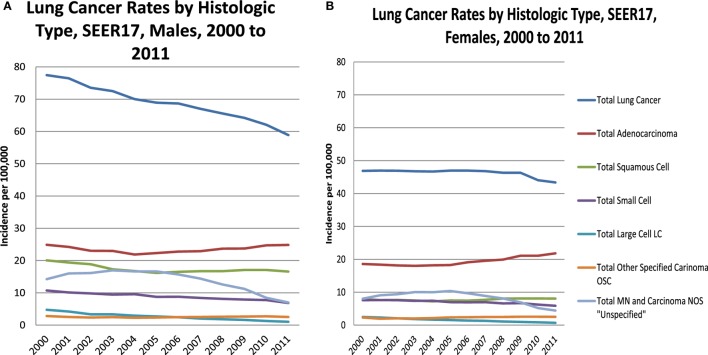
Lung cancer rates by histologic type, males (A) and females (B), 2000–2011, SEER17, excluding Alaska.